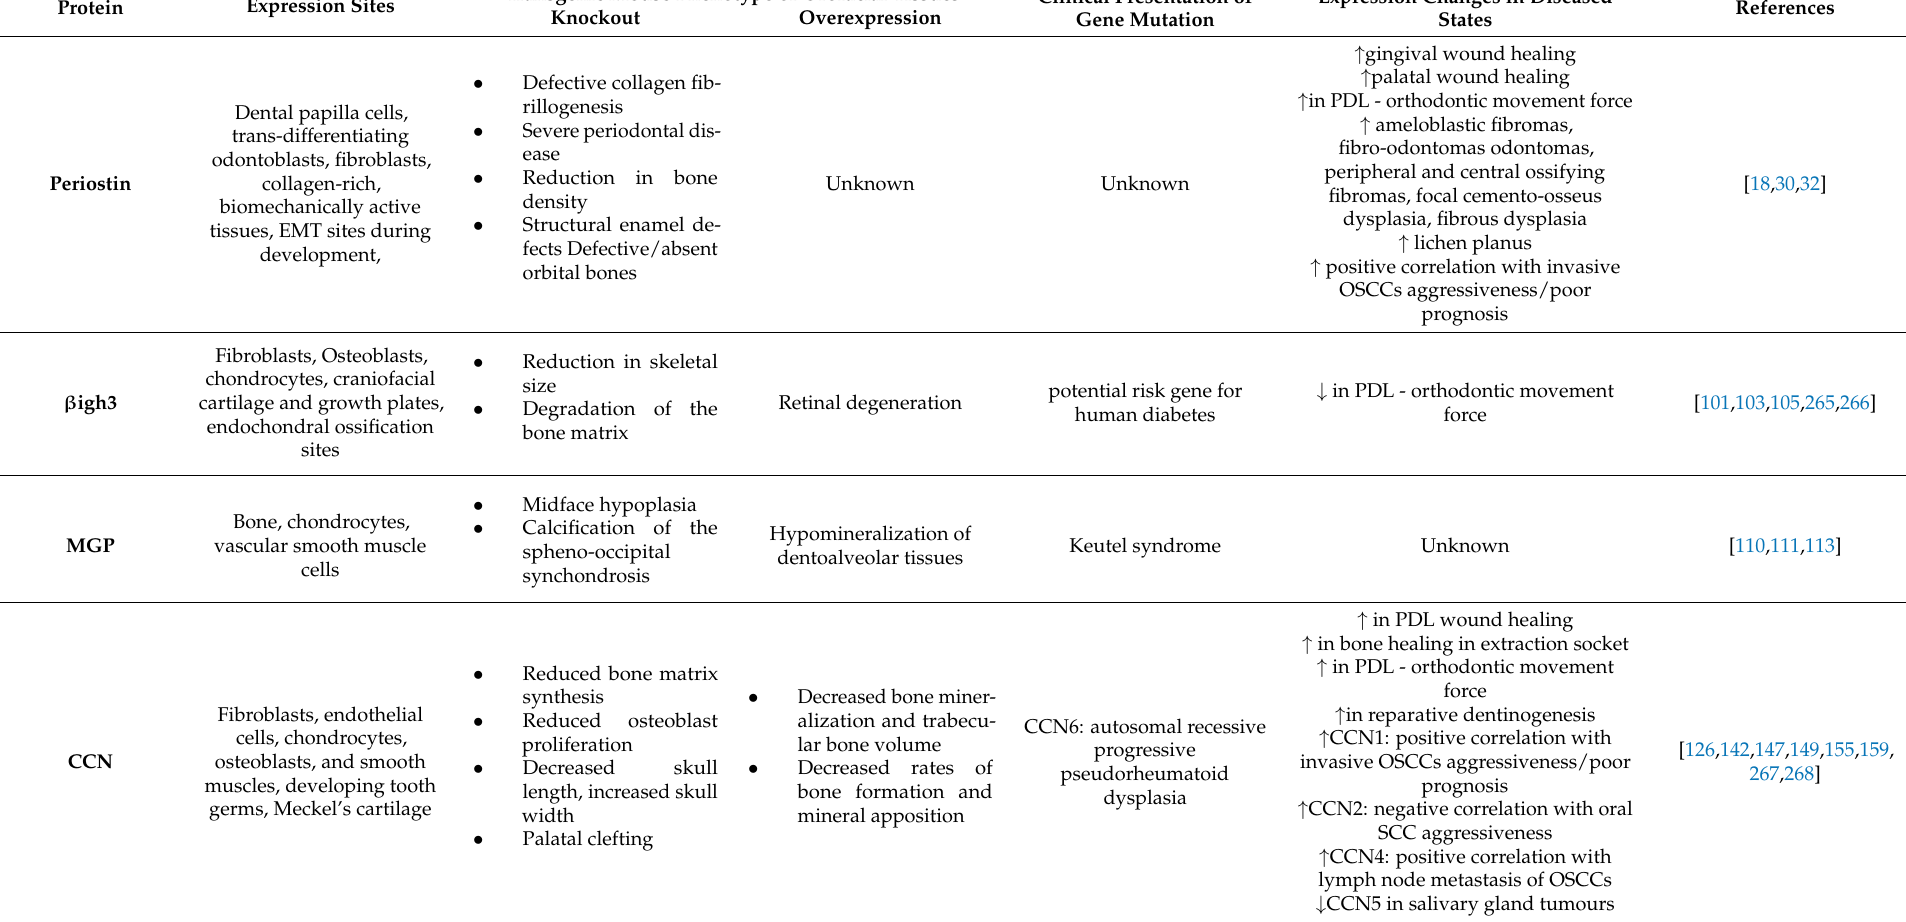
Table 1. Summary of matricellular protein expression, transgenic animals’ phenotype, and involvement in disease and pathology in orofacial tissues.